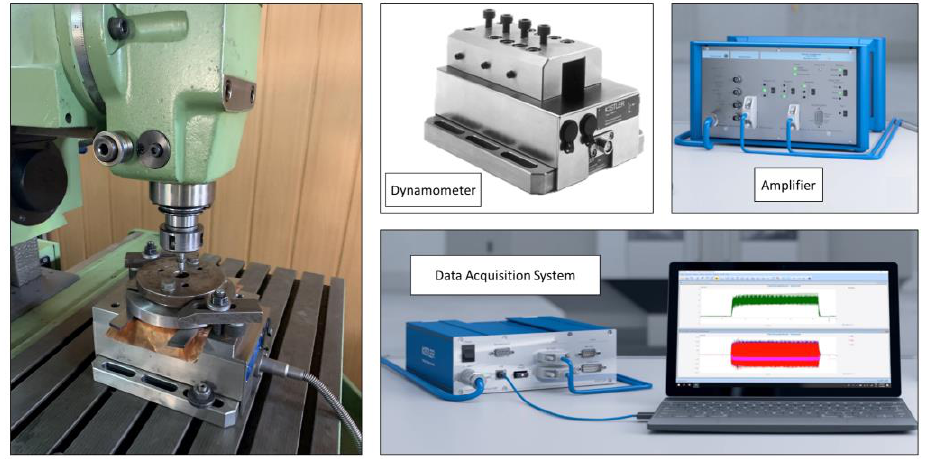
Figure 5. Dynamometer setup for thrust force measurement.